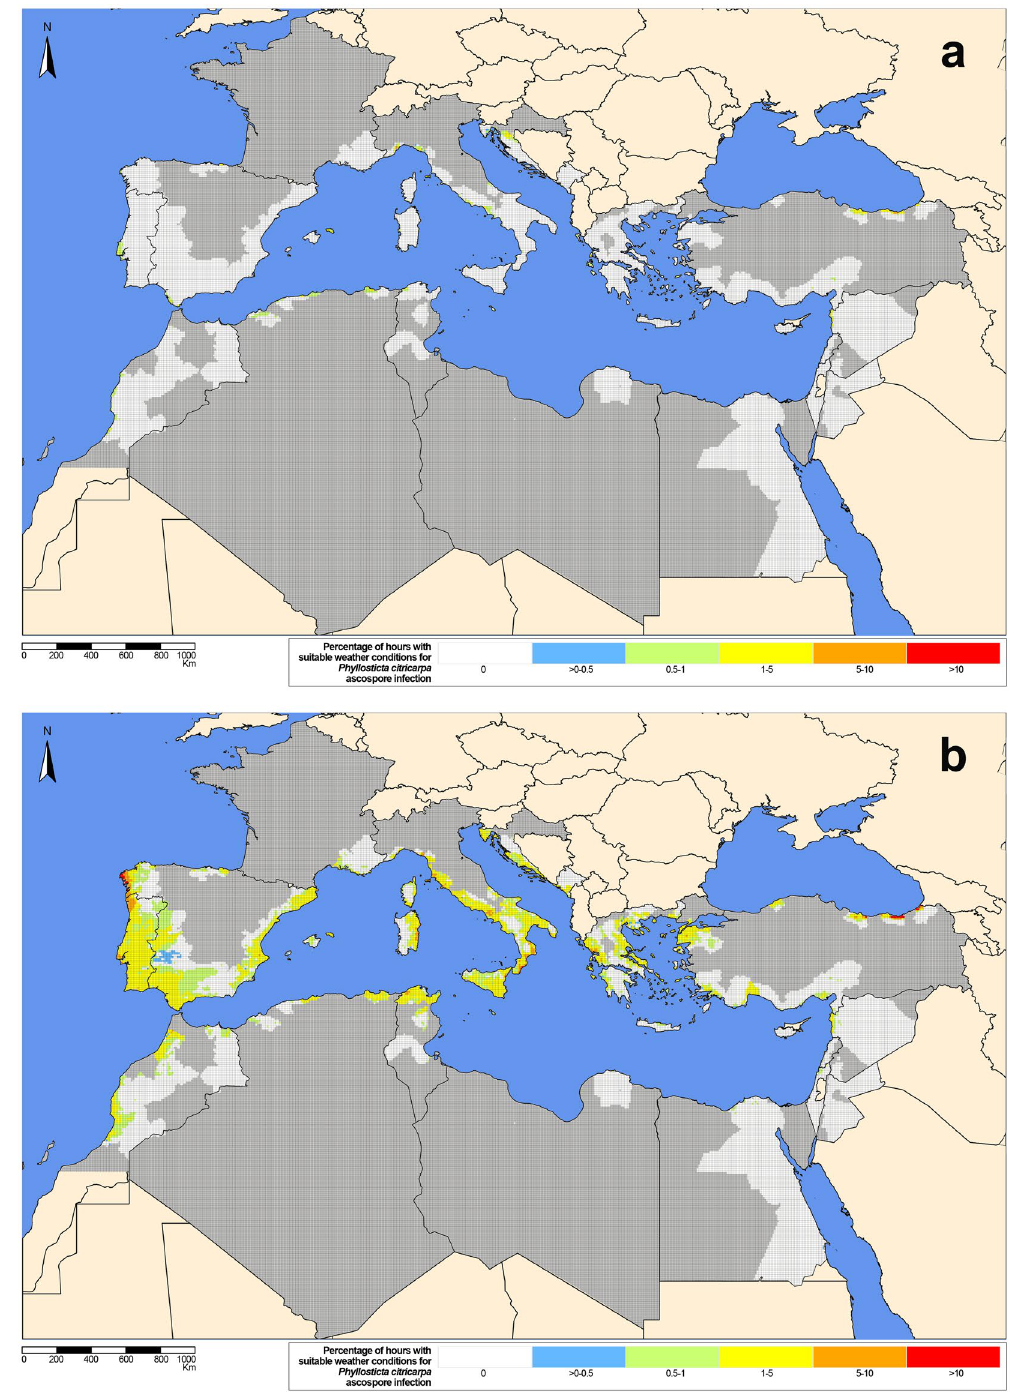
Figure 1. Percentage of hours ( = 0 white, ]0–0.5] blue, ]0.5–1] green, ]1–5] yellow, ]5–10] orange, > 10 red) with suitable weather conditions for Phyllosticta citricarpa ascospore infection (generic infection model for foliar fungal pathogens by Magarey et al. 33 , configuration scenario S1) for the 9-km grid interpolated climatic data of the citrus-growing regions in the Mediterranean Basin from 2009 to 2018 for ( a ) spring (March to May) and ( b ) autumn (September to November). Non citrus areas inside citrus-growing countries in dark-grey. The maps were created by the authors using the software R 3.6.0, https:// www.R- proje ct.